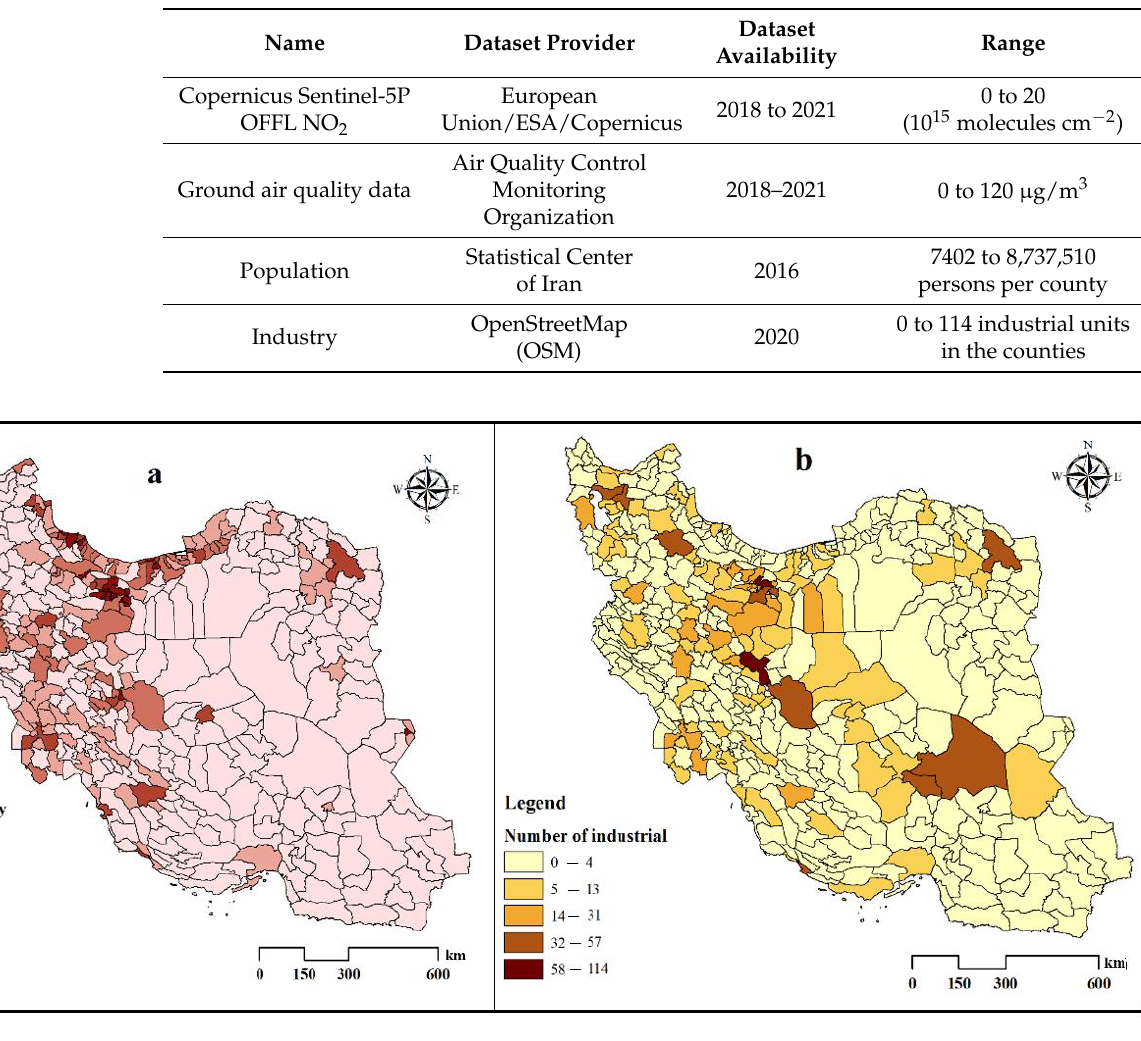
Figure 2. Data used: ( a ) the population density (person per km 2 ) and ( b ) the number of industrial units in Iran.